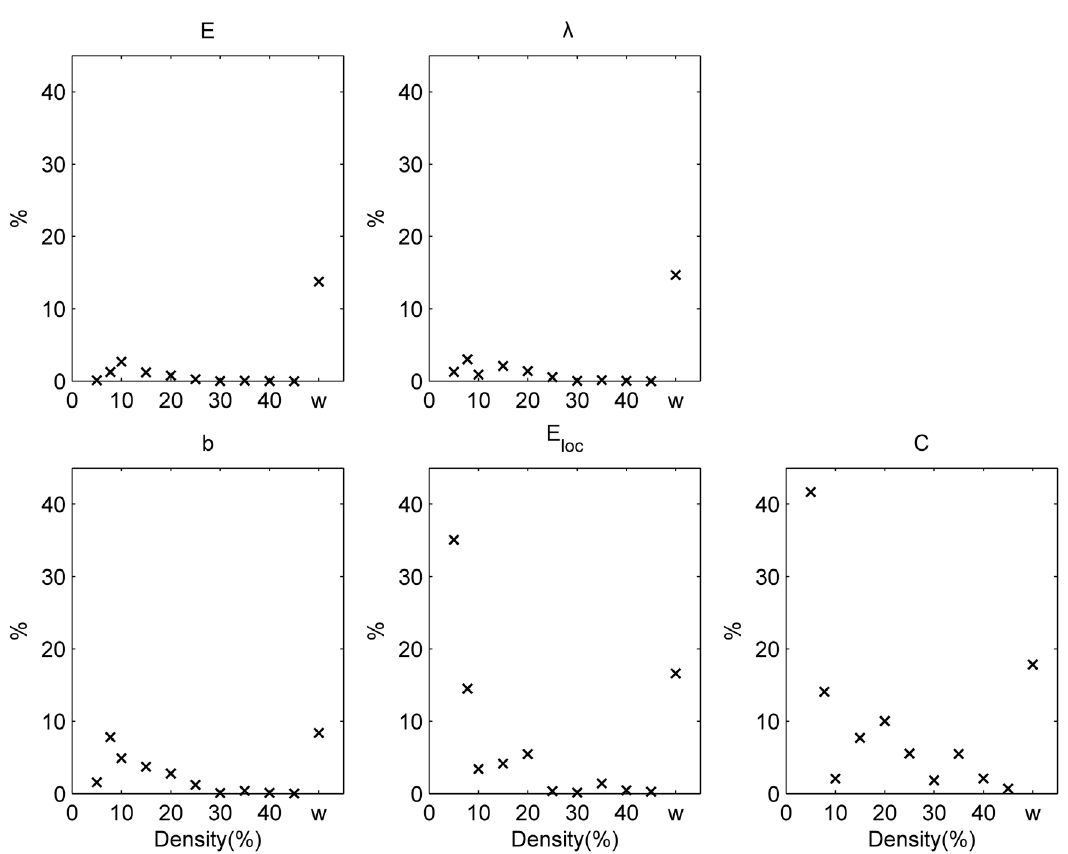
Fig. 4. Test-retest variability (%) between independent groups for binary (over a range of densities) and weighted (w) networks. E : global efficiency; l : the characteristic path length; b : the mean betweenness centrality; E loc : the mean local efficiency; C : the mean clustering